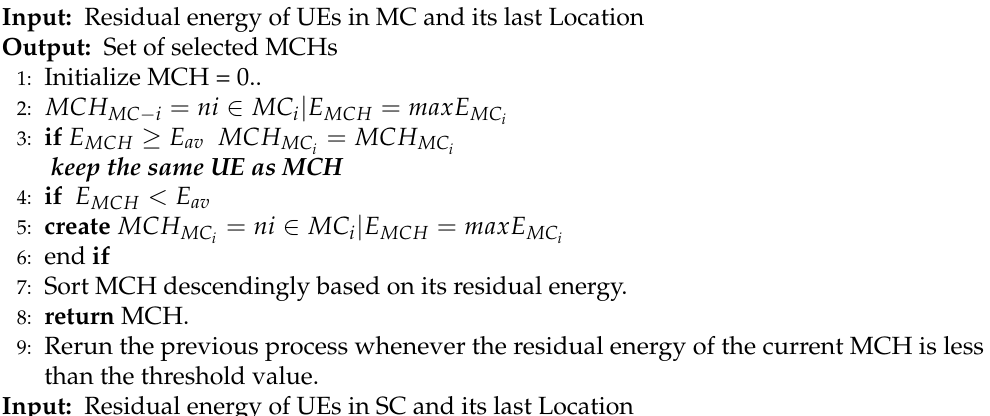
Algorithm 2 CFT stage 2: MCH and SCH